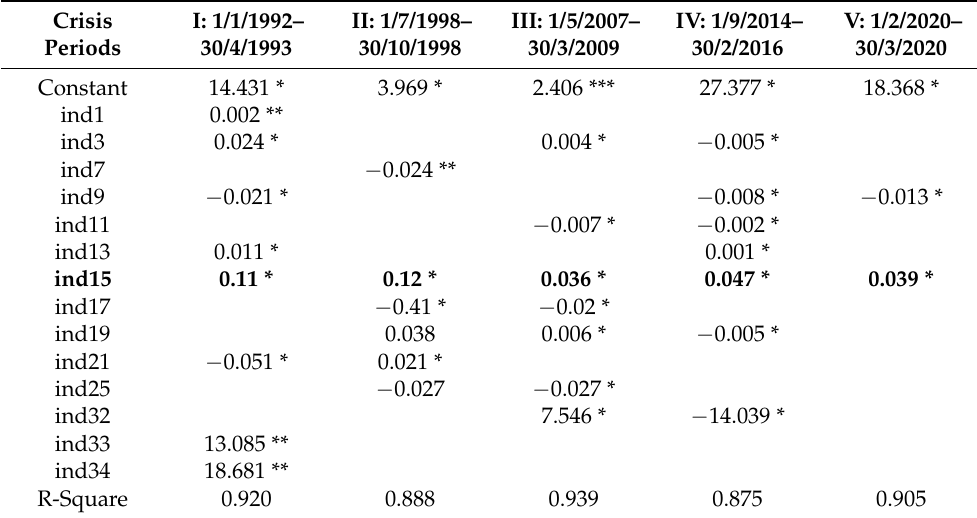
Table 5. Indexes in multiple linear regression models of the Royal Bank of Canada during the 5 crisis